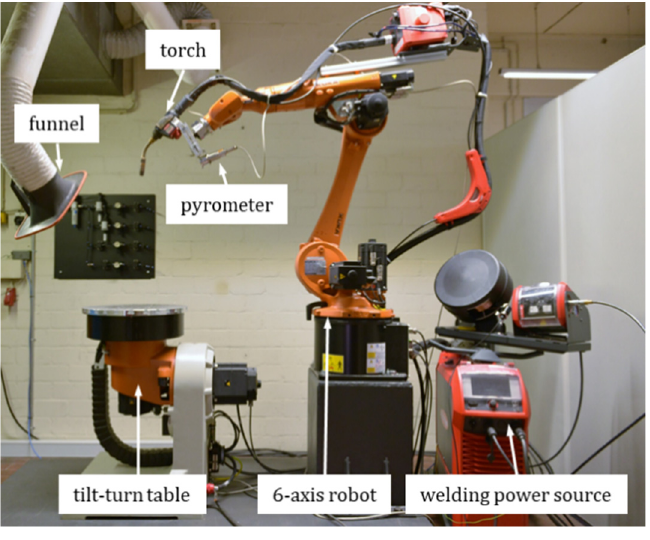
Figure 8. Experimental set-up.